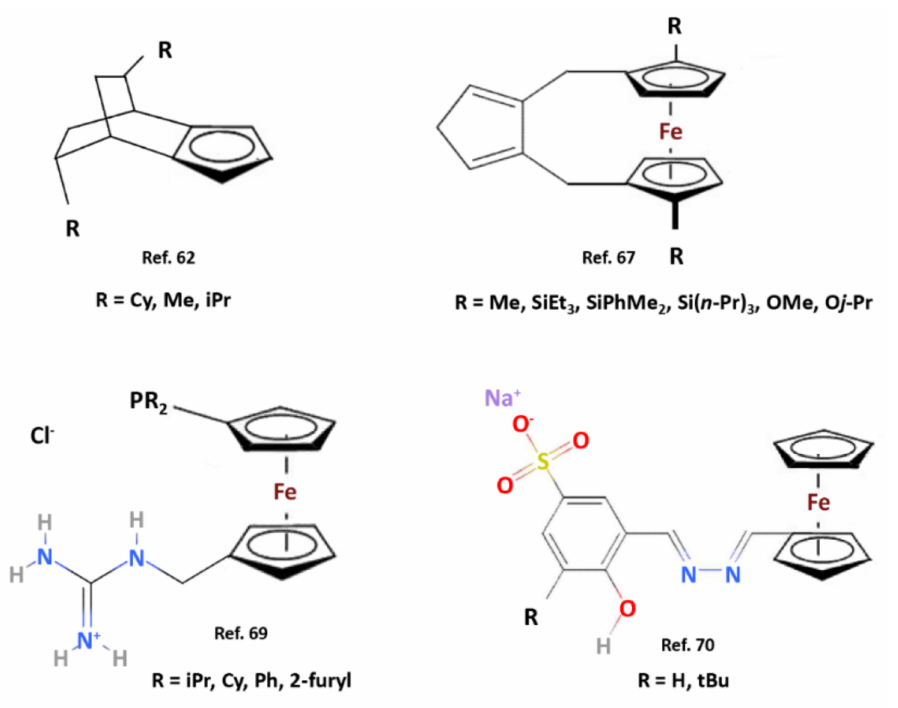
Figure 3. Molecular structures of some ferrocenyl-based ligands in recent literature. 1,2,3,4,5-pentamethylcyclopentadienyl ligand, briefly Cp* (or C 5 Me 5 ), is a Cp